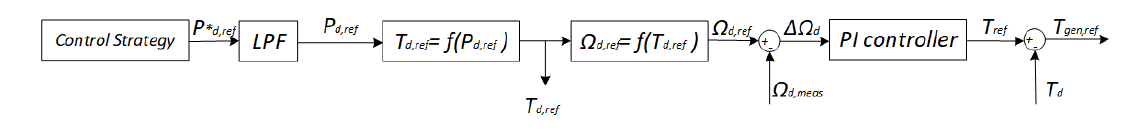
Figure 9: Supervisory control of series hybrid